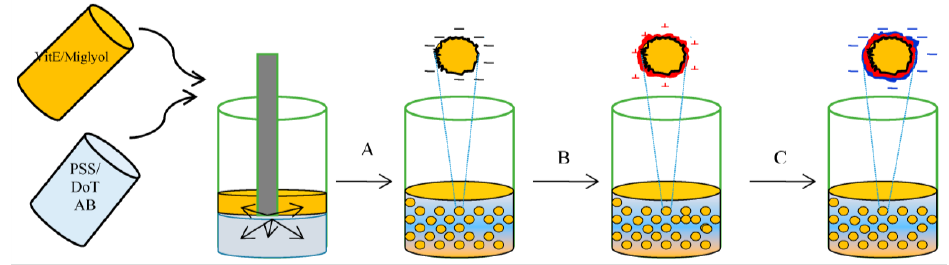
Figure 2. Steps of Vitamin E microencapsulation: А—emulsification; B—LBL (chitosan); C—LBL (PSS); according to [24].